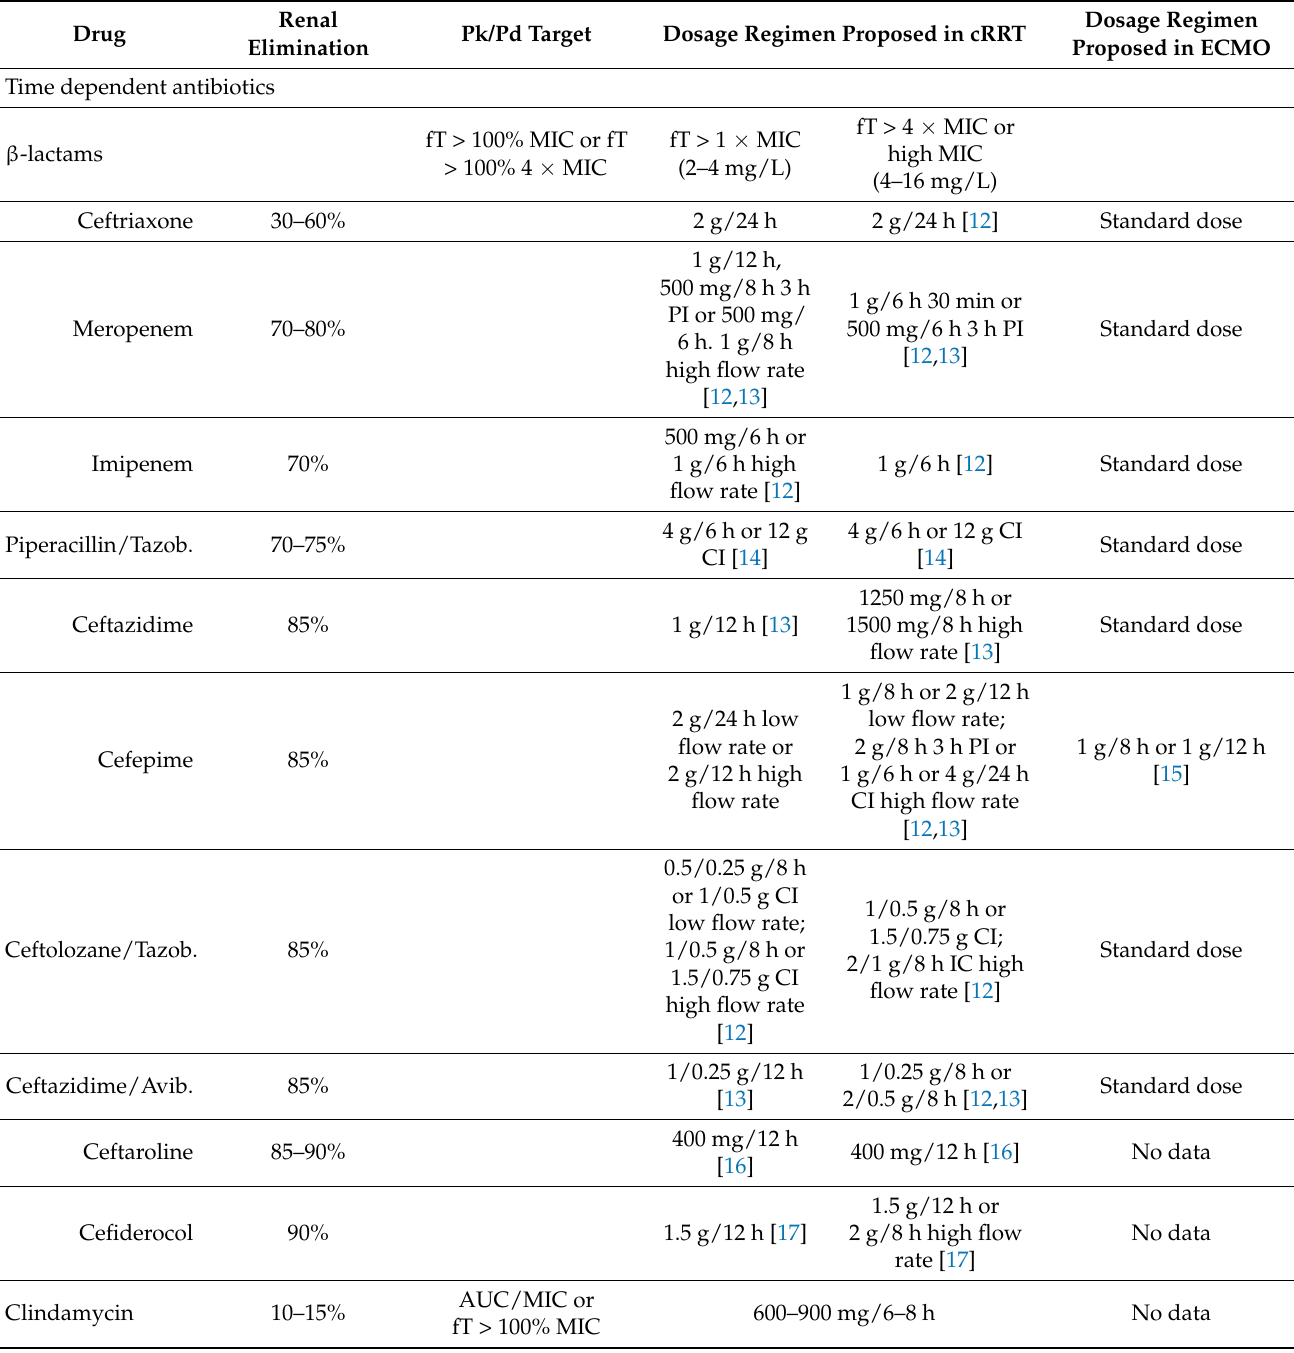
Table 1. Characteristics of antibiotics and variations in critically ill patients, CRRT and/or